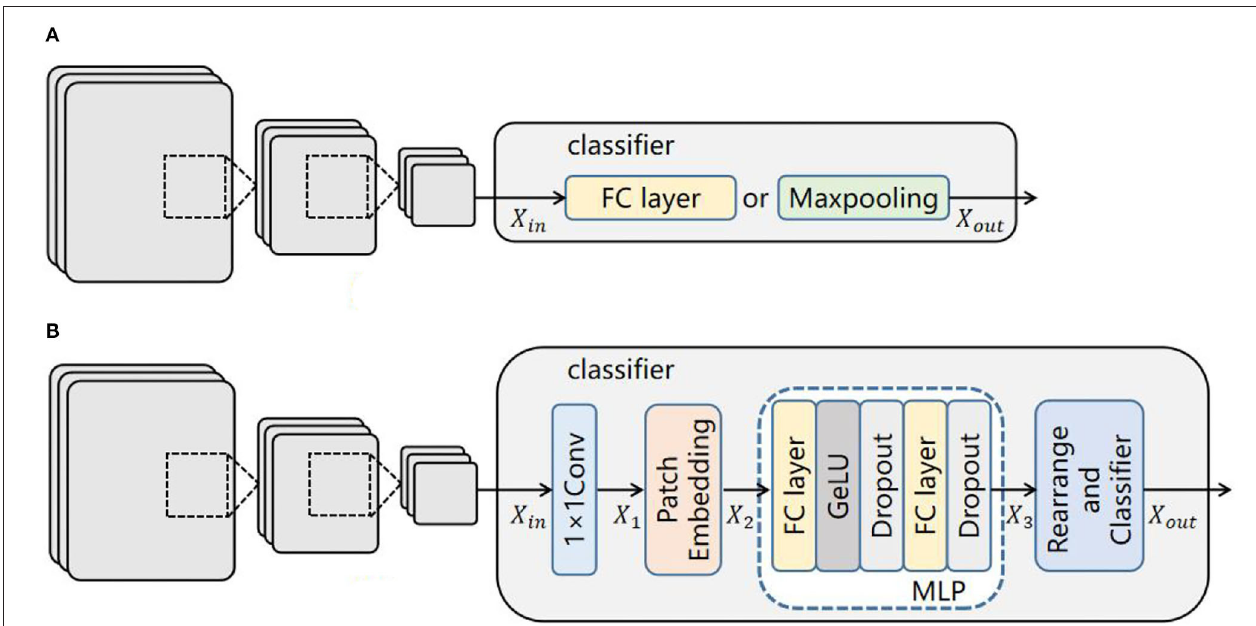
FIGURE 5 | Comparison of classifier structures: (A) classifier structure of CNNs; (B) our classifier structure.